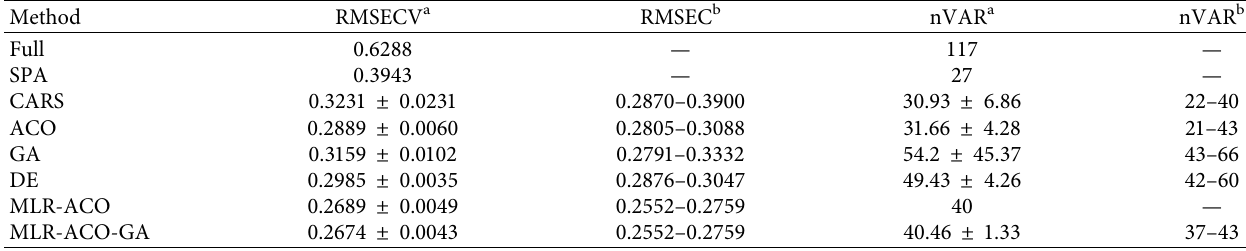
Table 2: Te results of diferent methods on the grain protein